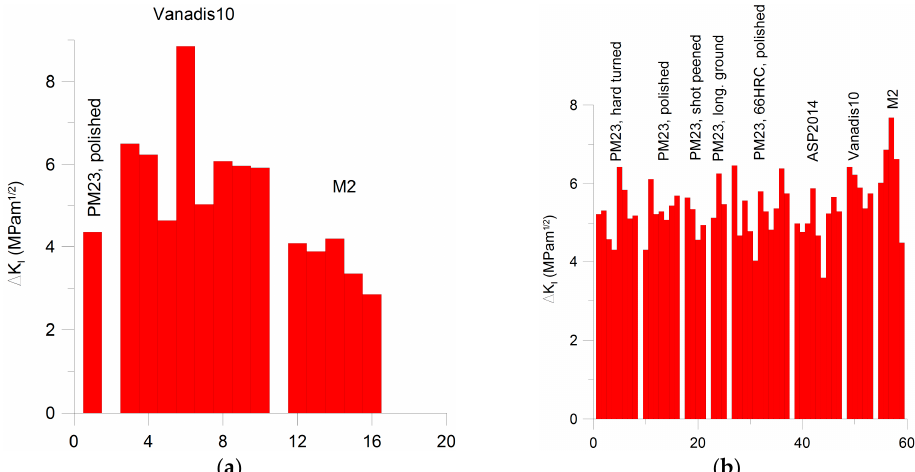
Figure 12. Stress intensity factors ( a ) found in three types of tool steels based on carbides after ref. [22]; ( b ) found in four different tool steels at different conditions, based on inclusions after ref. [22]. Based on the different inclusion and carbide populations, a defect is defined as critical if its stress K Δ , calculated through Equation (25), coupled with intensity exceeds the threshold for propagation, th D , as shown is therefore data as shown in Figure 12a,b. The critical size of a particle, c